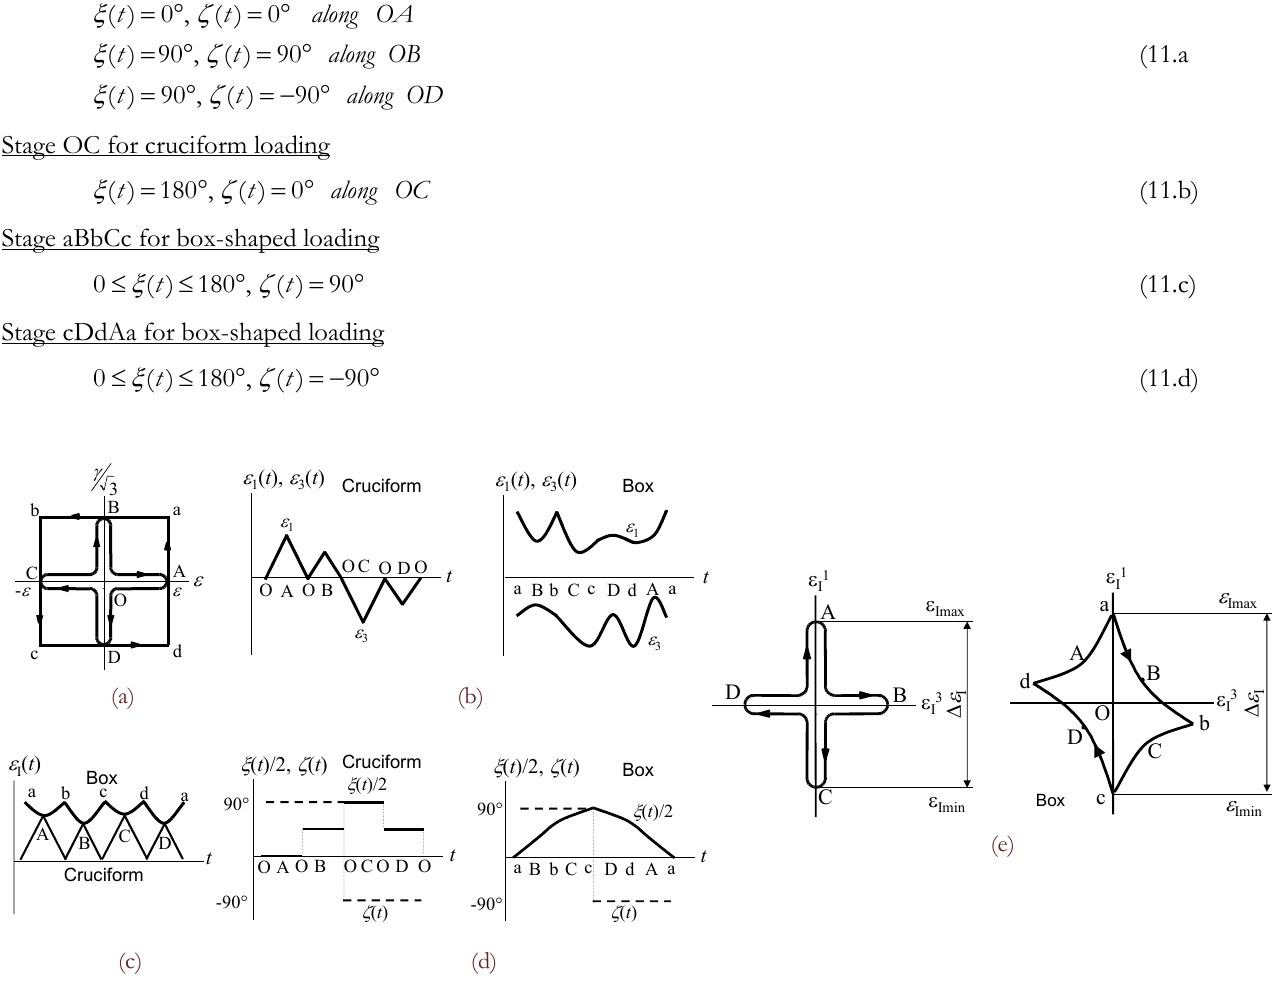
Figure 5: Variations of  i (t),  I ( t ) and  ( t )/2 in non-proportional straining: (a) Strain paths on  /  3 plot, (b) Variation of  i ( t ), (c) Variation of  I ( t ), (d) Variation of  ( t ) and  ( t ), (e) Strain paths on polar